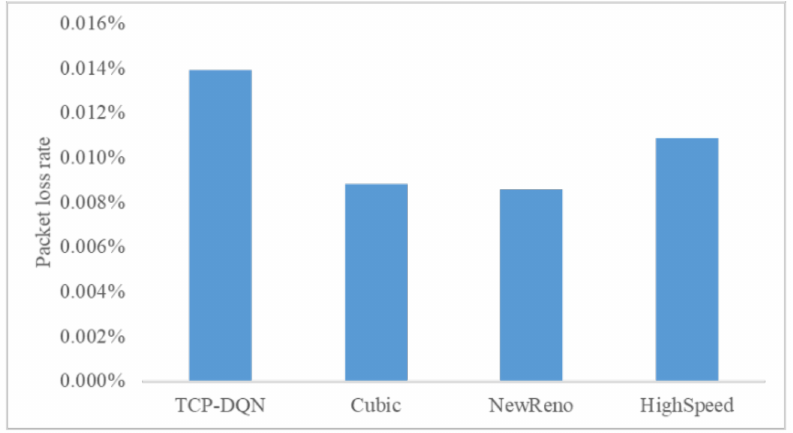
Figure 8. Comparison of packet loss